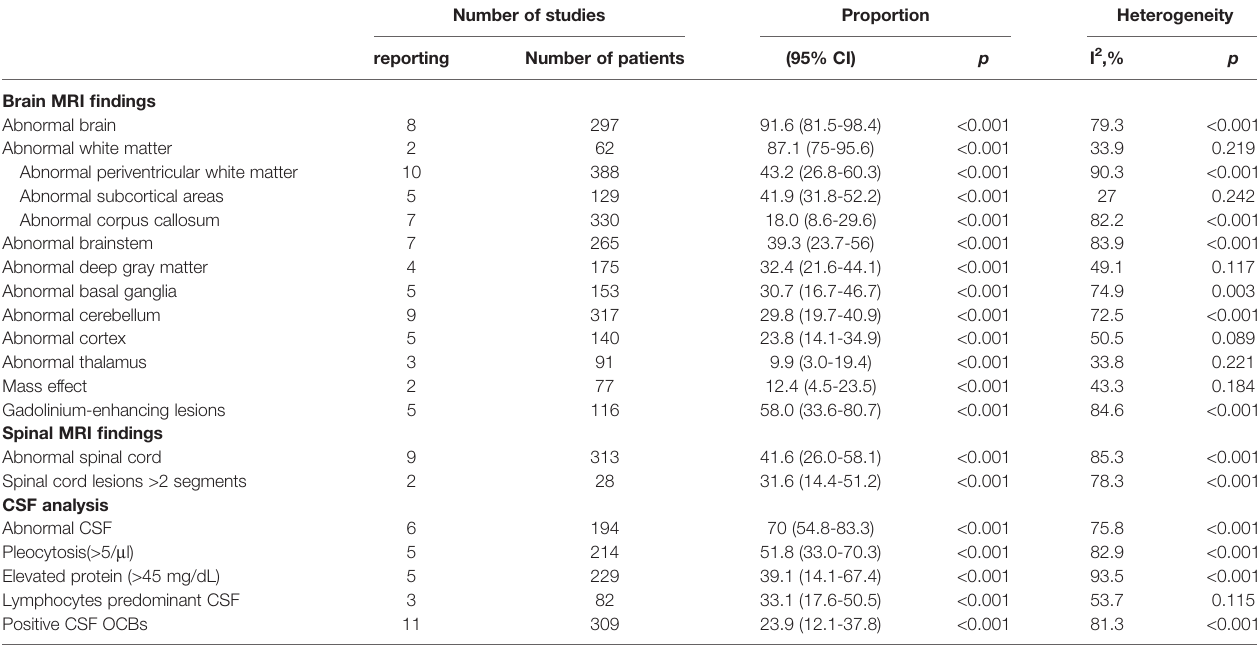
MRI, magnetic resonance imaging; CSF, cerebrospinal fl uid; OCBs, oligoclonal bands.